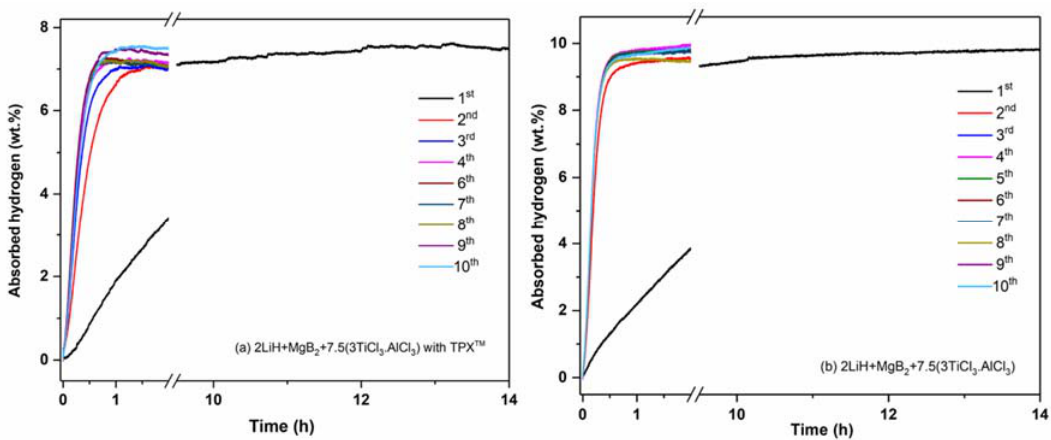
Figure 1. Hydrogenation profiles and cycling capability of the composites Li ‐ RHC d +7.5(3TiCl 3 ∙ AlCl 3 ) with TPX TM ( a ) and without TPX TM scaffold ( b ).